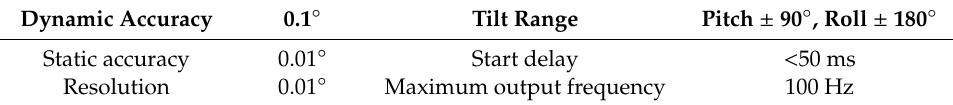
Figure 6. The Stewart platform for the MEMS inclinometer testing. Table 1. Micro-electro-mechanical system (MEMS) inclinometer characteristics.